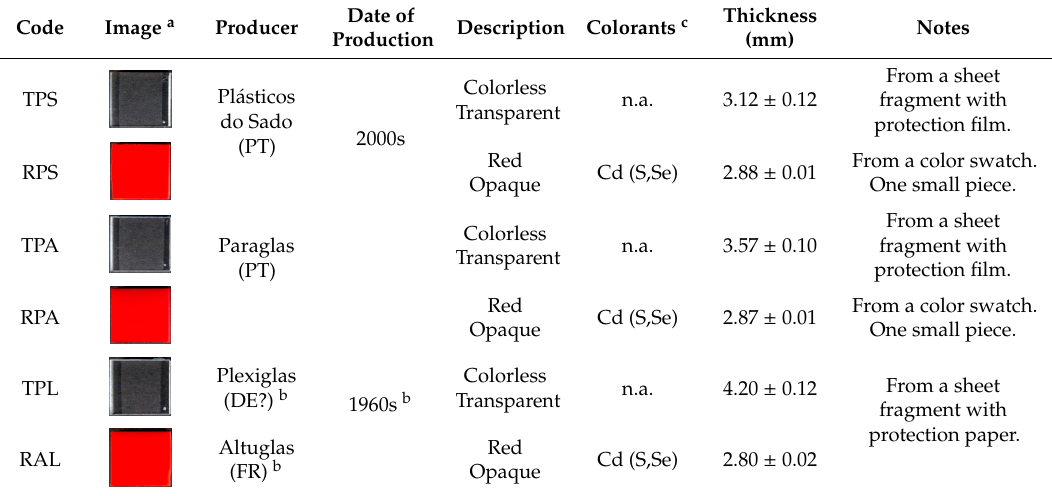
Table 2. Identification codes of the test samples and corresponding details.